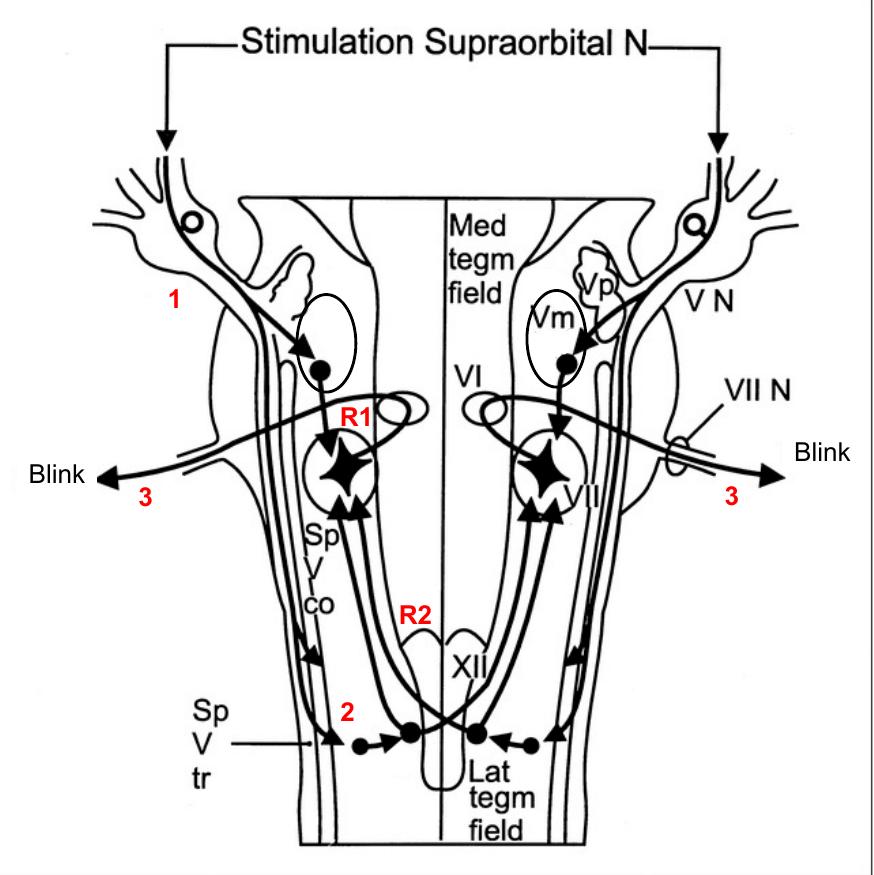
Figure 1. Schematic representation of the blink reflex pathways. The stimulus is perceived by the ipsilateral supraorbital nerve (1) and is conducted to the trigeminal motor nucleus (Vm), where the ipsilateral early response (R1) is obtained via an oligosynaptic pathway to the facial nucleus. The nociceptive stimulus is also conducted from the supraorbital nerve to the lower brainstem, including the caudal spinal trigeminal nuclei (2), via a long descending spinal tract of the trigeminal nerves (Sp V tr). After multiple interconnections, an ascending efferent impulse is then conducted bilaterally to VII (3) and consequently results in a bilateral late electrophysiological response (R2) and a visible bilateral eyeblink. Sp V co, spinal trigeminal complex; VI, abducens nucleus; VII N, facial nerve; VN, trigeminal sensory root; XII, hypoglossal nucleus; Lat tegm field, lateral tegmental field; Med tegm field, medial tegmental field. Modified from [15] and used with permission from the author.